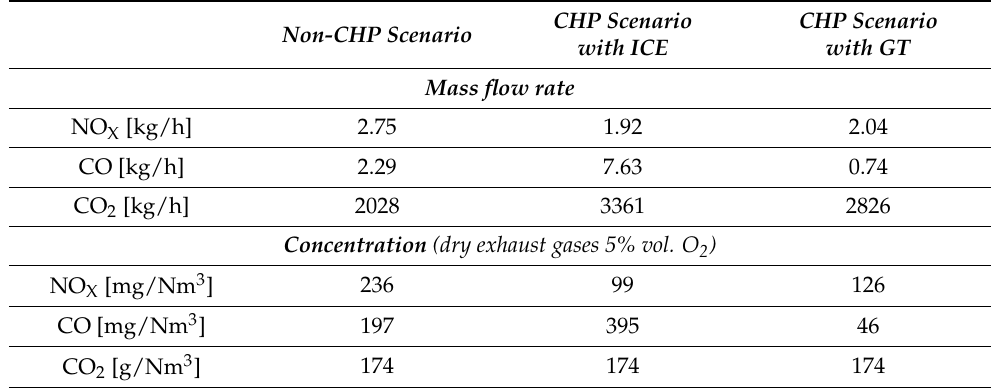
Table 10. Pollutant emission results for non-CHP and CHP scenarios.